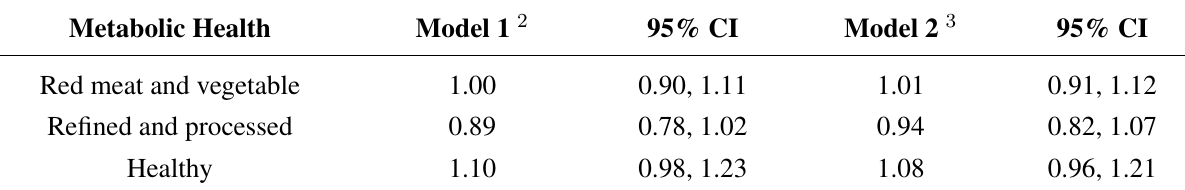
Table 5. Odds ratios for metabolic health 1 , according to dietary